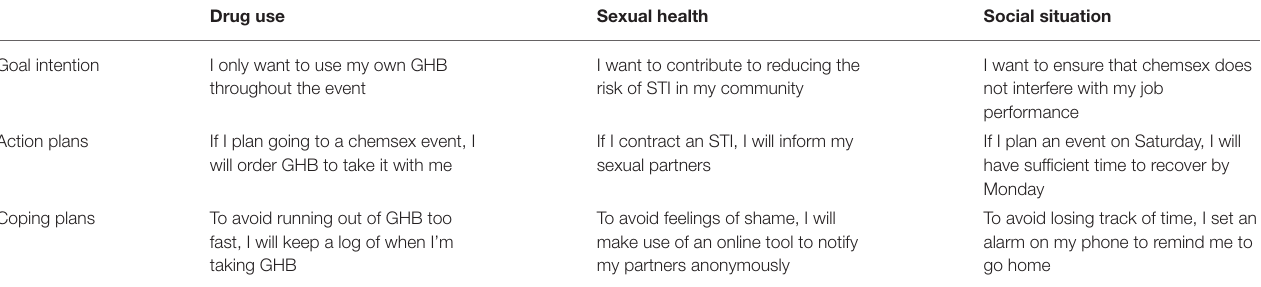
TABLE 1 | Examples of goal intentions, action plans and coping plans for the self-control of sexualized drug use and to mitigate potential health and social impacts. Drug